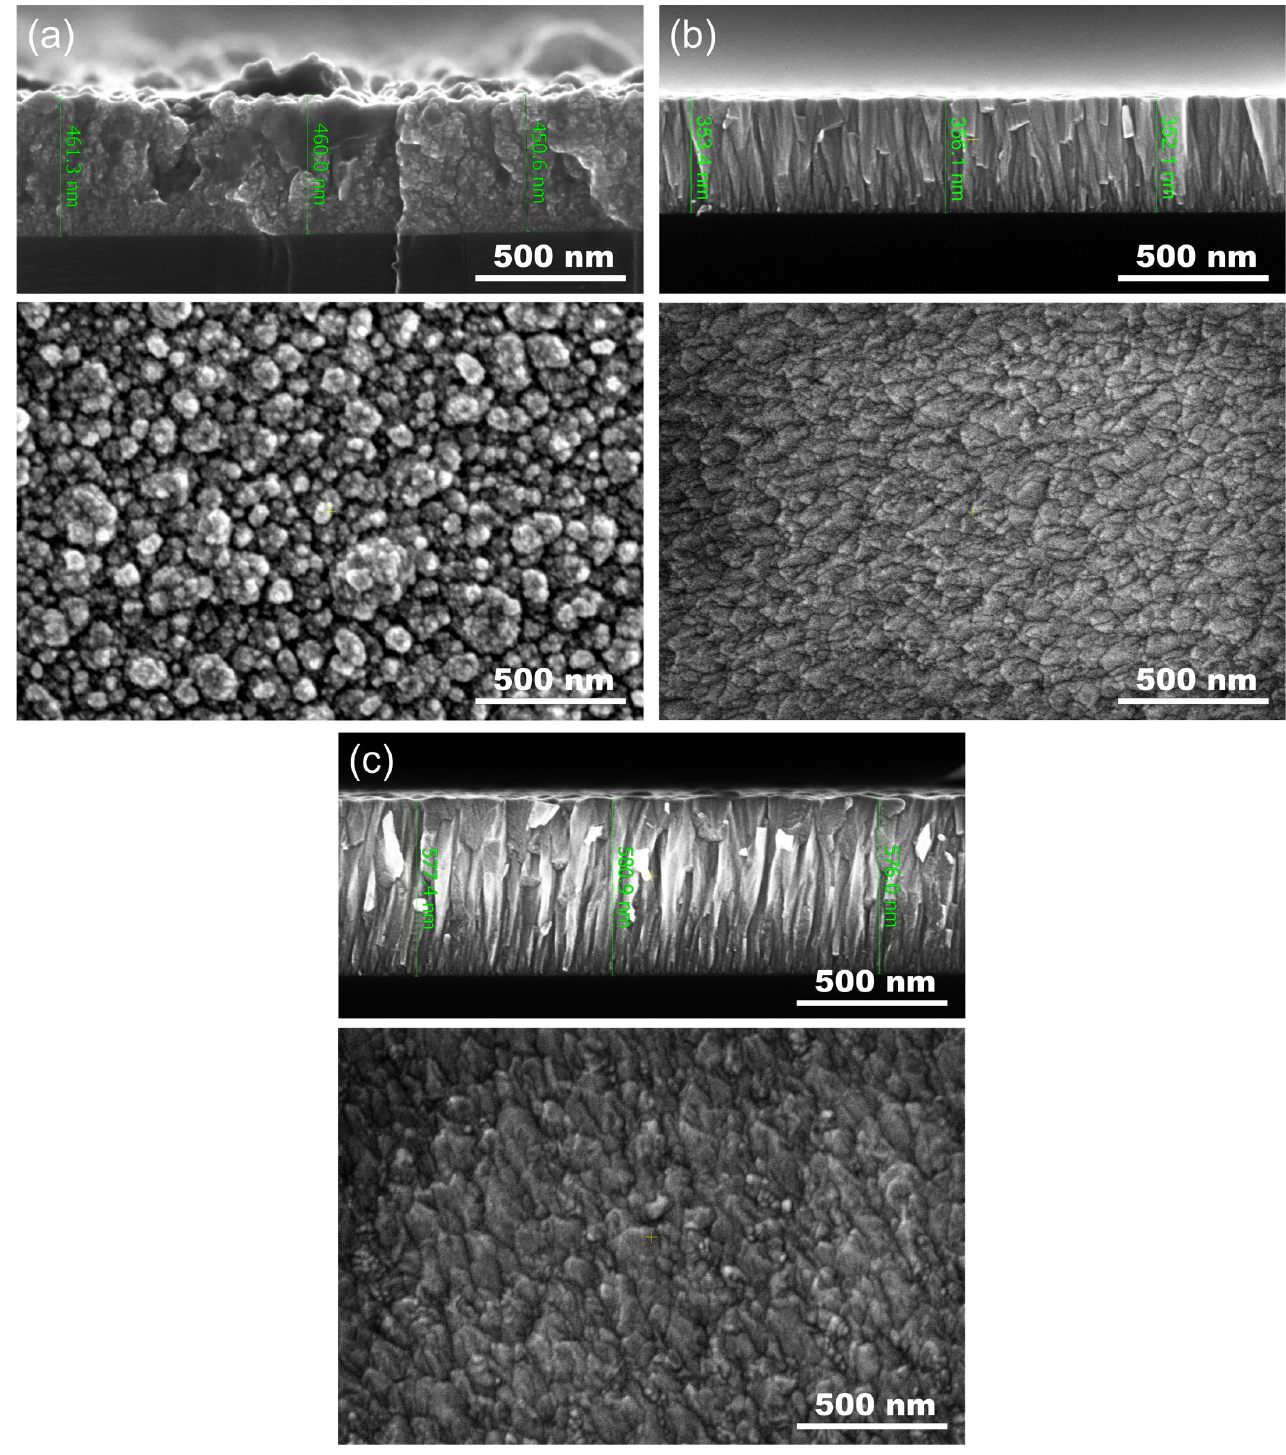
Figure 6. SEM images of ZnOx thin films deposited in modes: ( a ) metallic, ( b ) shallow dielectric and ( c ) deep dielectric. ( c ) deep